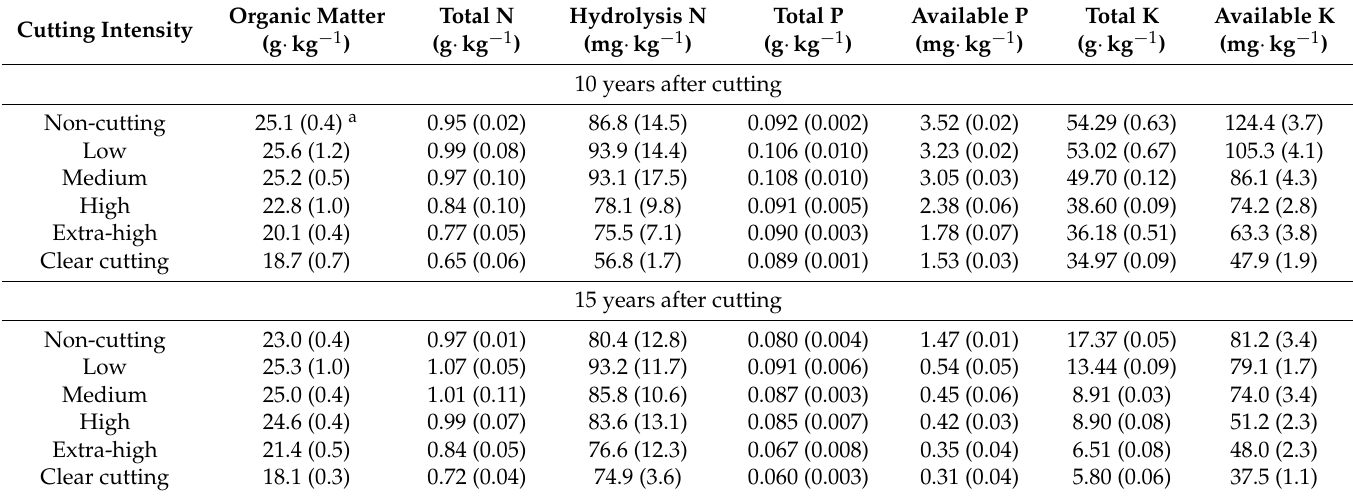
Table 5. Means and standard deviations of soil chemical properties 10 and 15 years after cutting.